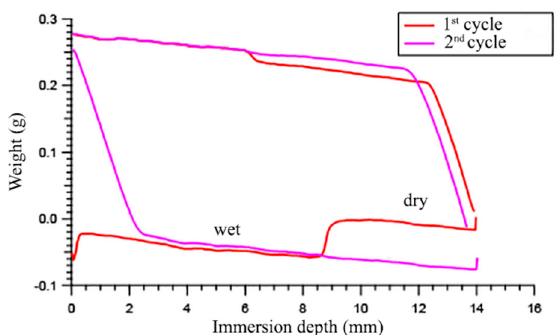
Figure 3. Wilhelmy plate force-immersion depth curves for the film S27SzA11: 1st cycle 8 mm depth/1000 s dwell time, and 2nd cycle 14 mm depth/10 s dwell time.